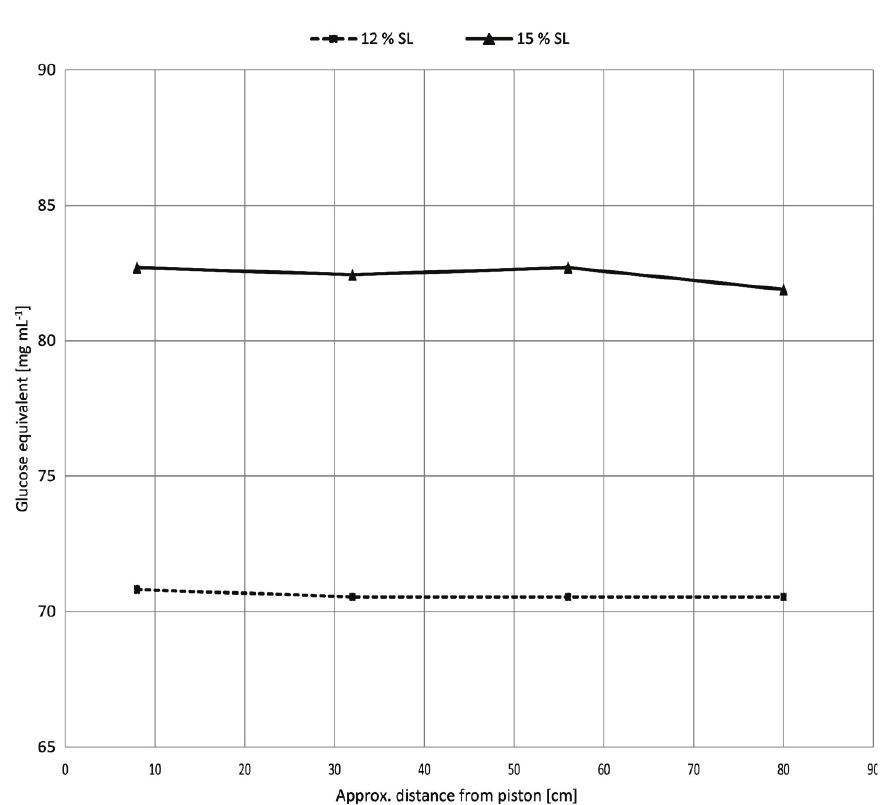
Fig. 7 – Glucose concentration distribution along the reactor length (0 at oscillator piston) (α-cellulose, 6 h, 10 mm amplitude, 3 mm baffle, 10 FPU, 50 °C)